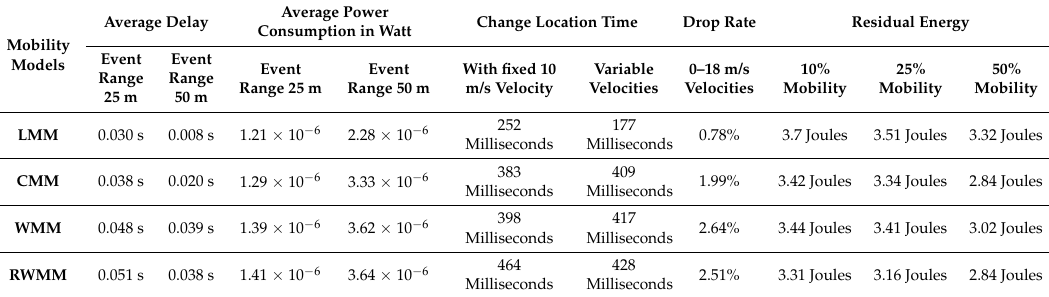
Table 4. Compression of LMM with other competing mobility models: CMM, WMM and RWMM.